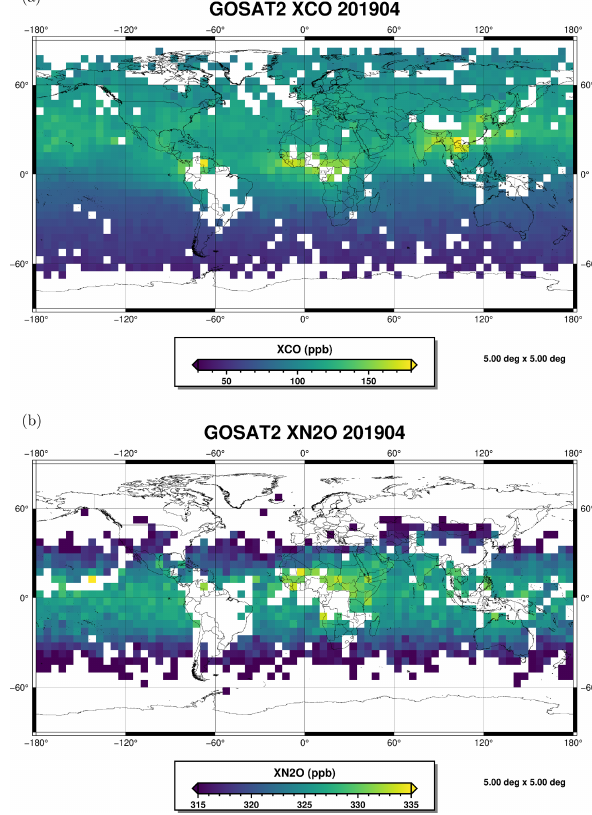
Figure 8. Maps of gridded GOSAT-2 data for April 2019: (a) XCO; (b) XN 2